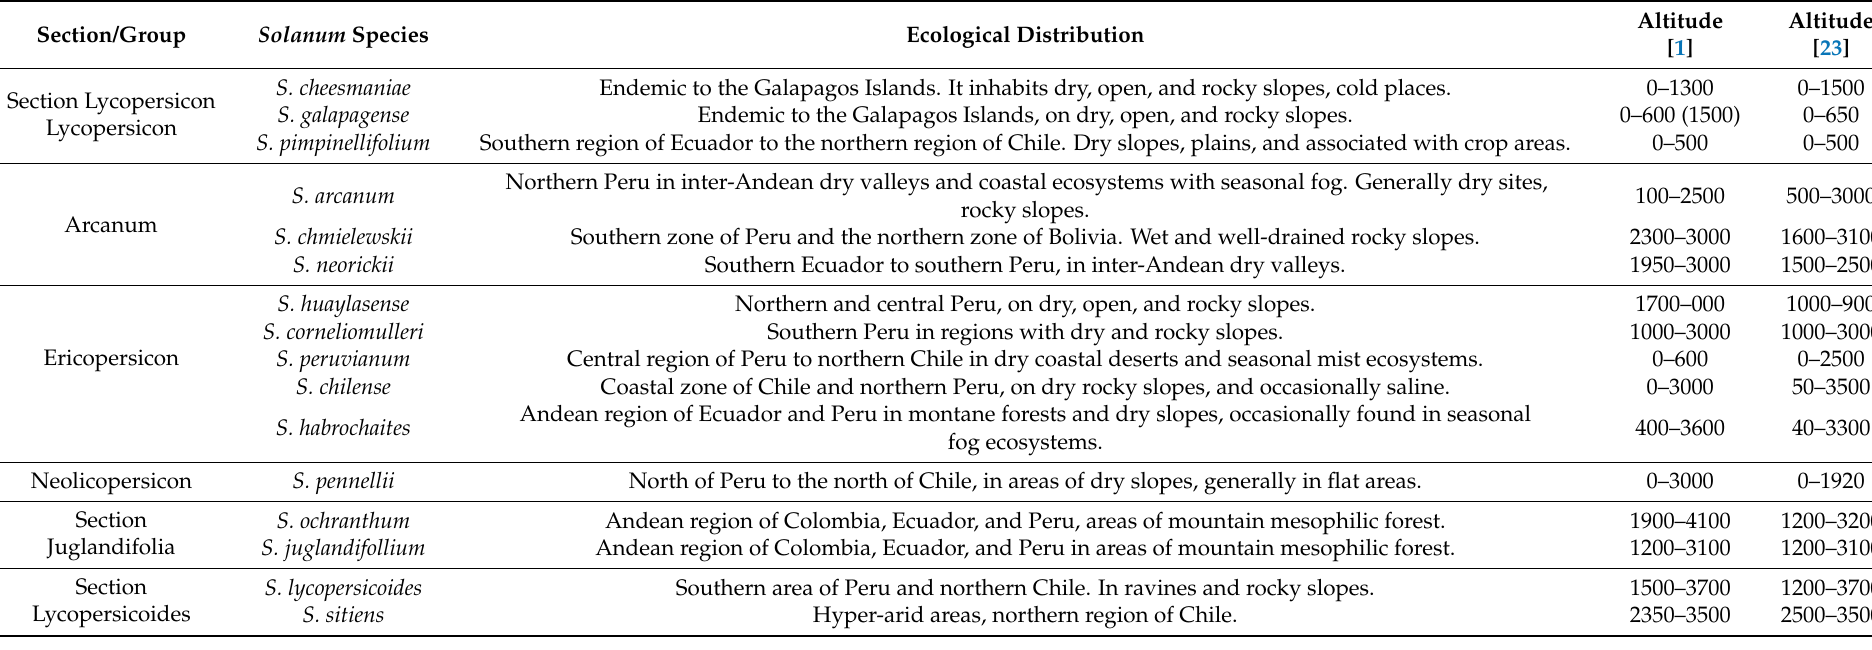
Table 1. Distribution and altitude (m above sea level) of 16 species of Solanum reported in two publications: Peralta et al. [1] and Grandillo et al. [23]. Species described according to taxonomic sections and groups proposed by Peralta et al.